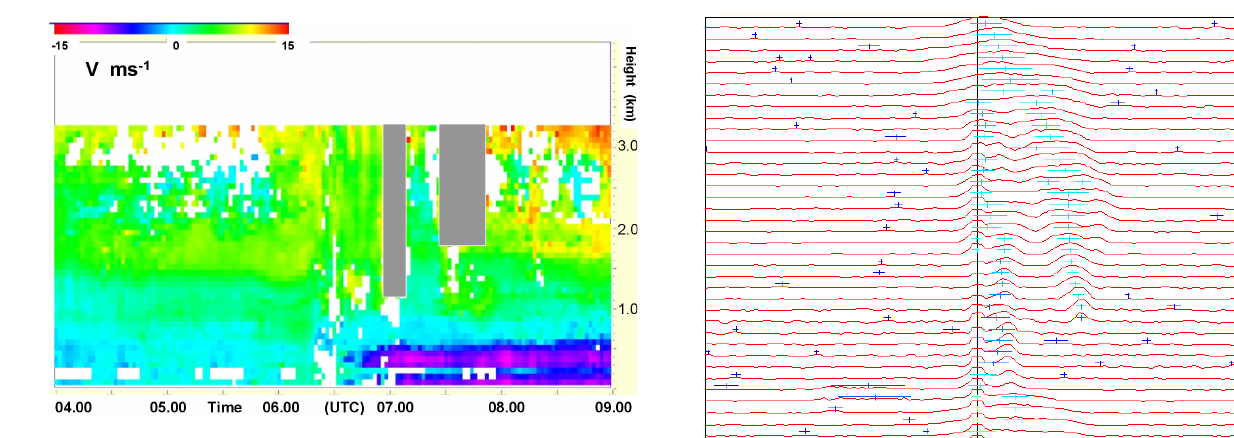
Fig. 4b. Wind V component measured by the wind profiler at Linkenholt 24 June 2005, 04:00 to 09:00UTC from 75 to 3250m a.g.l.